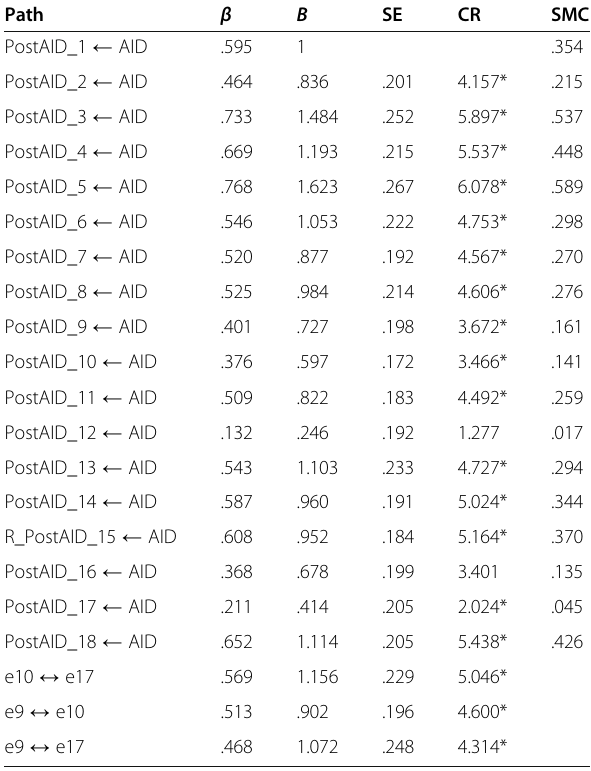
Table 2 Standardised and unstandardised coefficients for PostAID/Q with correlated errors